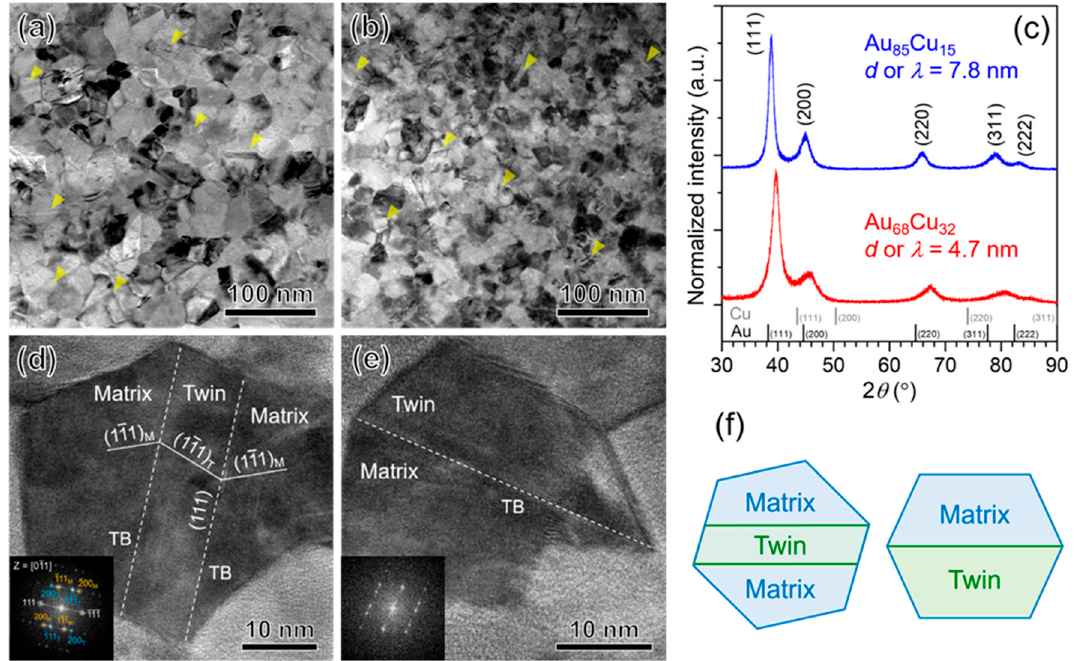
Figure 1. ( a , b ) Bright-field scanning transmission electron microscopy (STEM) images of as-electrodeposited Au 85 Cu 15 and Au 68 Cu 32 alloys. The arrows indicate the nanotwins inside the nanograins. ( c ) XRD patterns of Au 85 Cu 15 and Au 68 Cu 32 alloys. The vertical bars at bottom indicate the di ff raction peaks of pure Au and Cu. ( d , e ) Two representative high-resolution transmission electron microscopy (HRTEM) images taken from the Au 85 Cu 15 alloy. Zone axis: [011]. ( f ) Illustration of two types of the nanotwin in a nanograin.